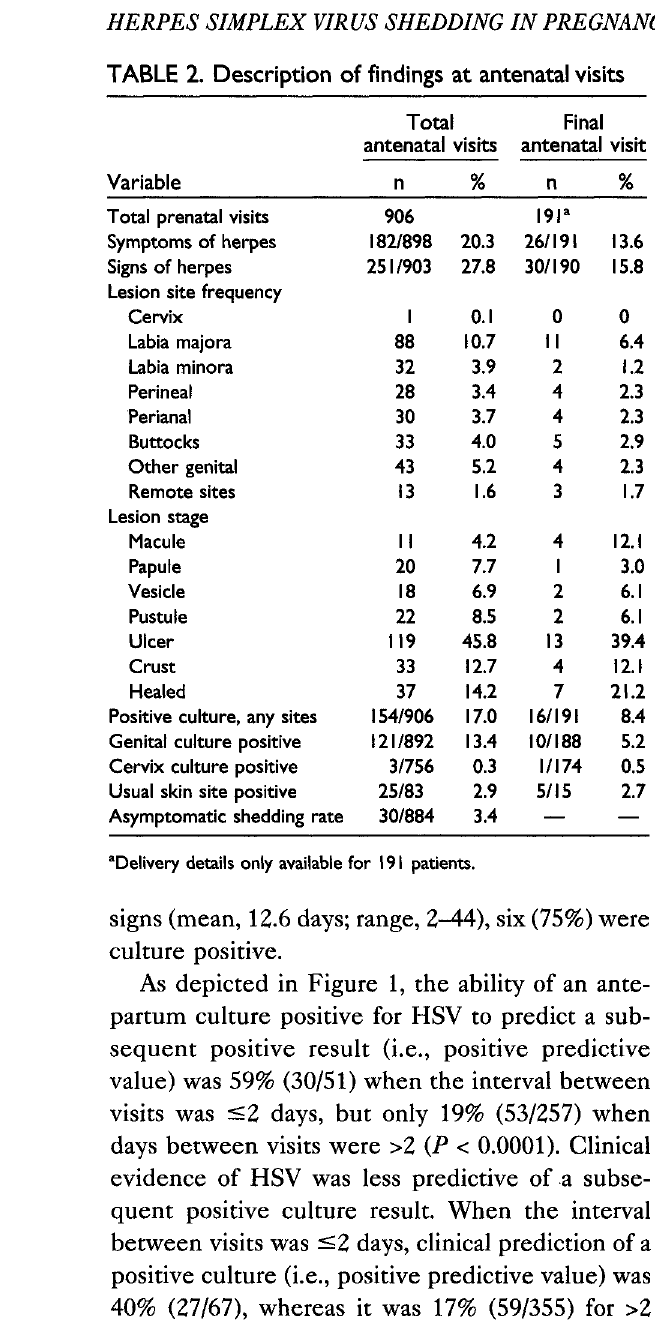
TABLE 2. Description of findings at antenatal